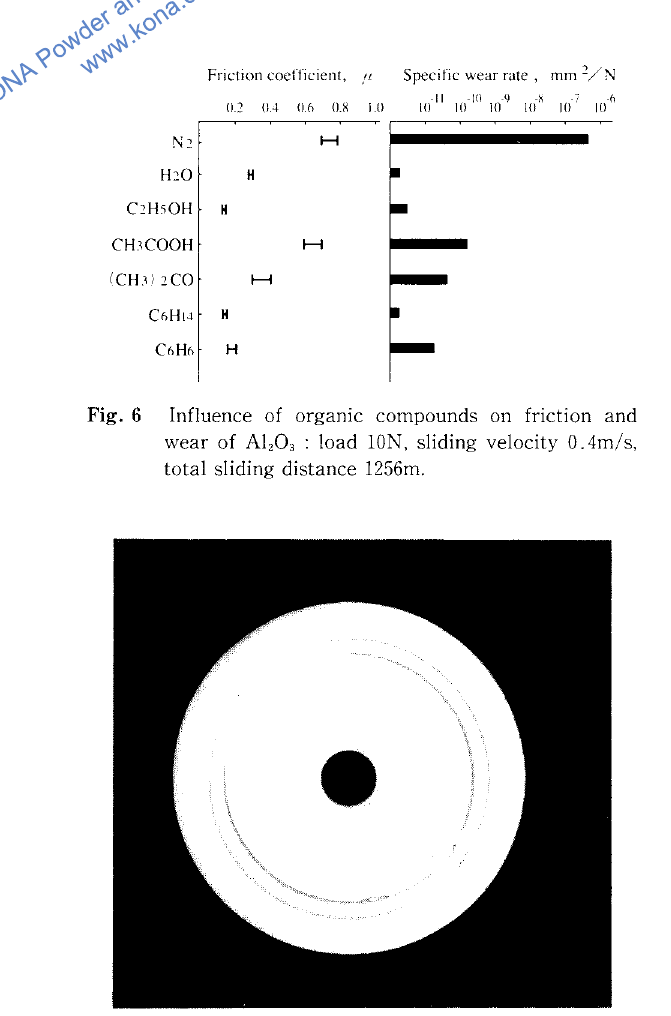
Fig. 7 Example of friction polymer like reaction product on alumina disk surface in atmosphere of benzene vapor.